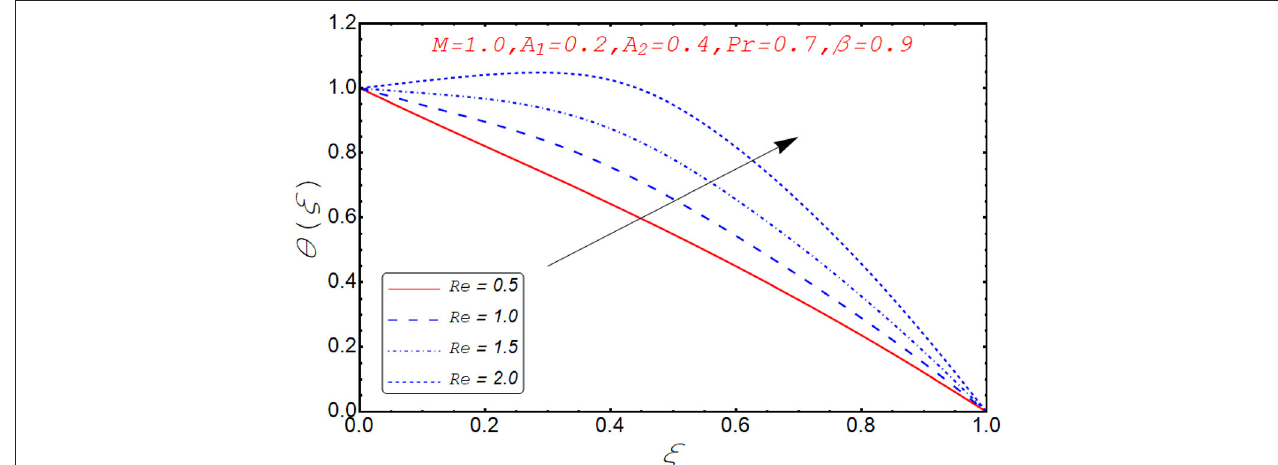
FIGURE 13 | Behavior of θ ( ξ ) for different Re .